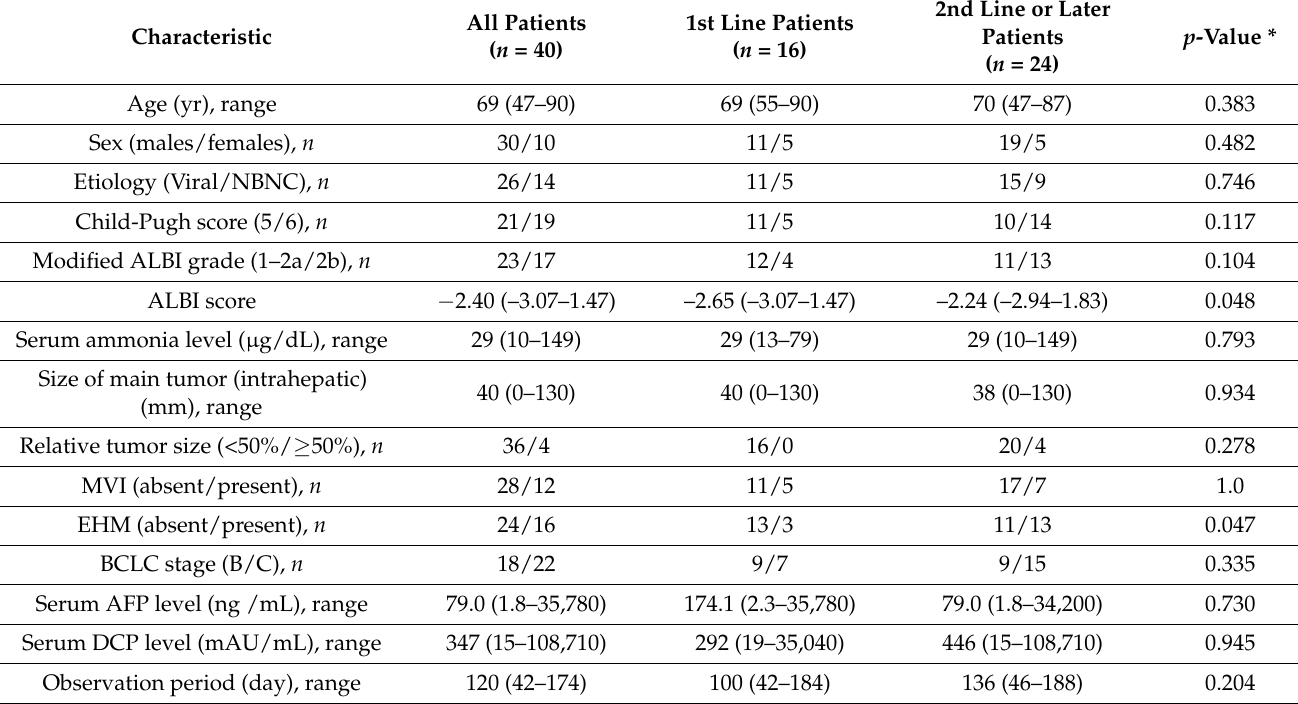
Table 1. Clinical background at initiation of atezolizumab plus bevacizumab combination therapy.